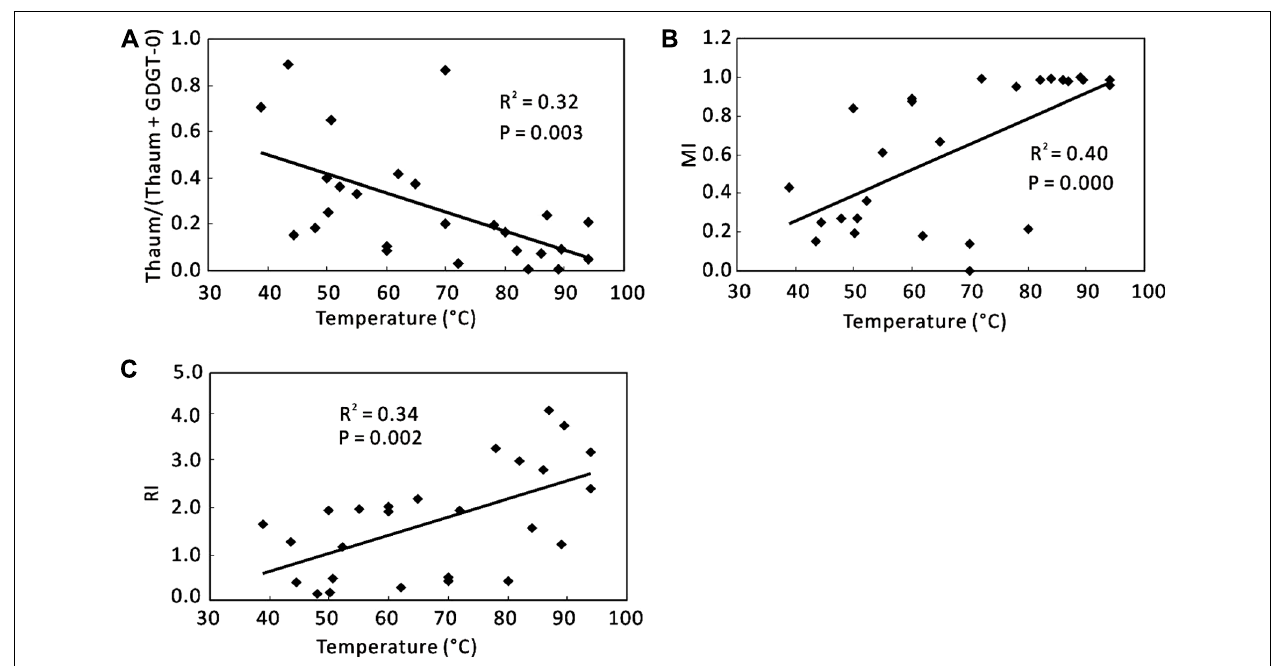
FIGURE 4 | Correlations between organic proxies and environmental parameters using total samples. (A) Thaum/(Thaum + GDGT-0) and temperature; (B) MI and temperature; (C) RI and temperature.Thaum,Thaumarchaeol.